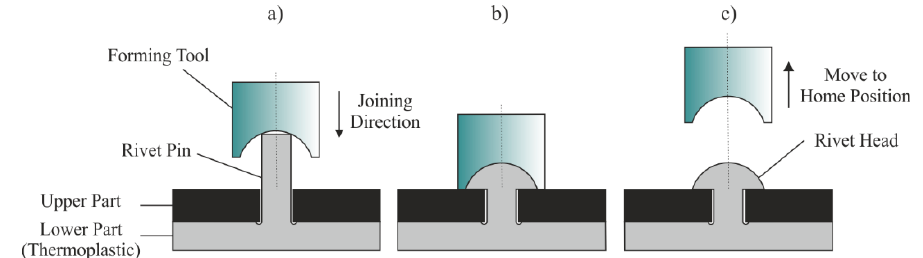
Figure 1. Main principle of a staking process, ( a ) before staking, ( b ) end position of the forming tool, ( c ) return of the forming tool after staking.